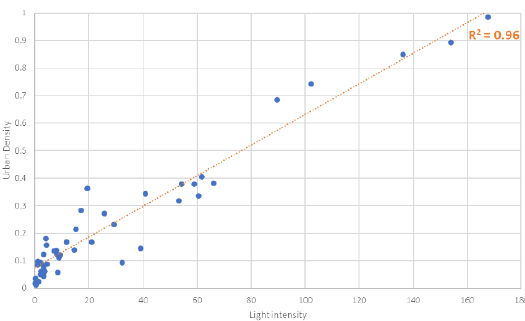
Figure 4. The 2016 light intensity extraction in EEC, Thailand at the sub-district